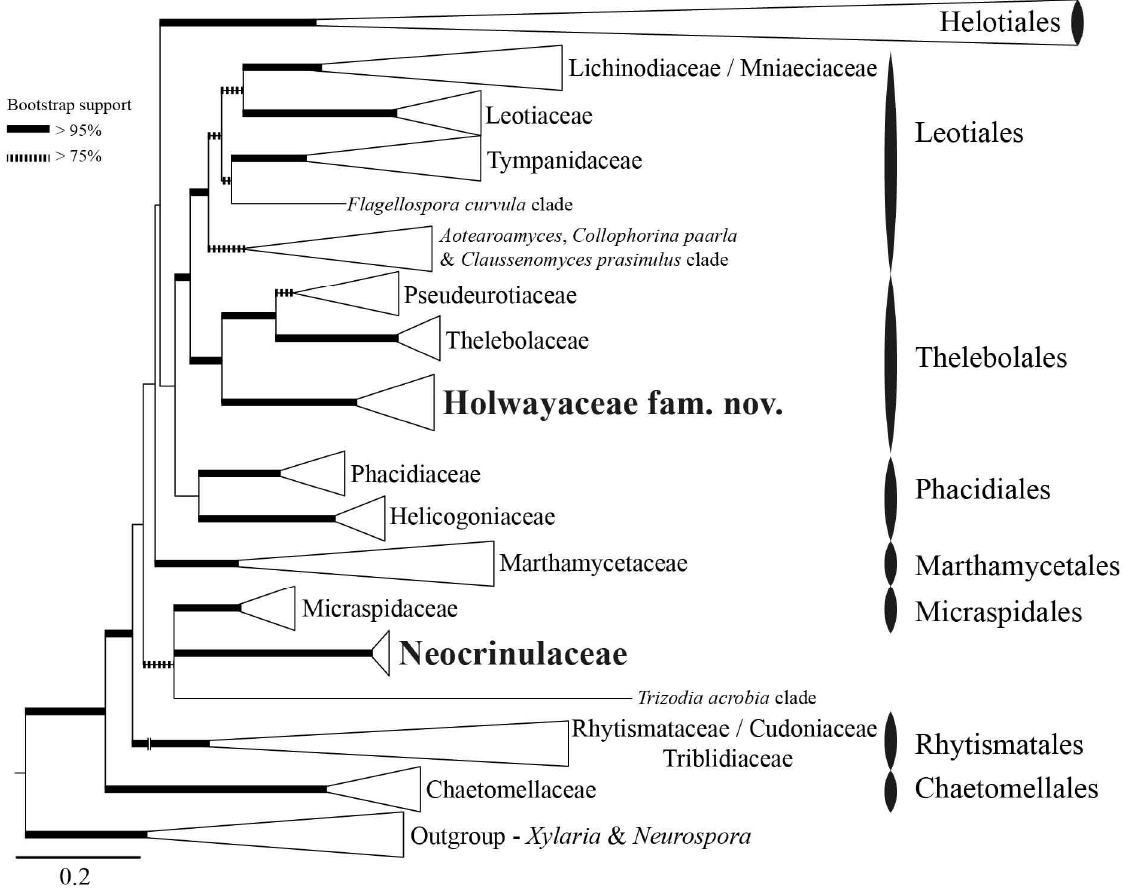
Figure 1. ML tree from concatenated DNA sequences. In bold we show the position of Holwayaceae fam. nov. and Neocrinulaceae inside Leotiomycetes . The collapsed clades represent the strongly supported family-level and order-level clades accepted by Johnston et al. [14]. Thick branches have bootstrap support (Bps) values > 95% and the dashed branches bootstrap support values 75–95%.